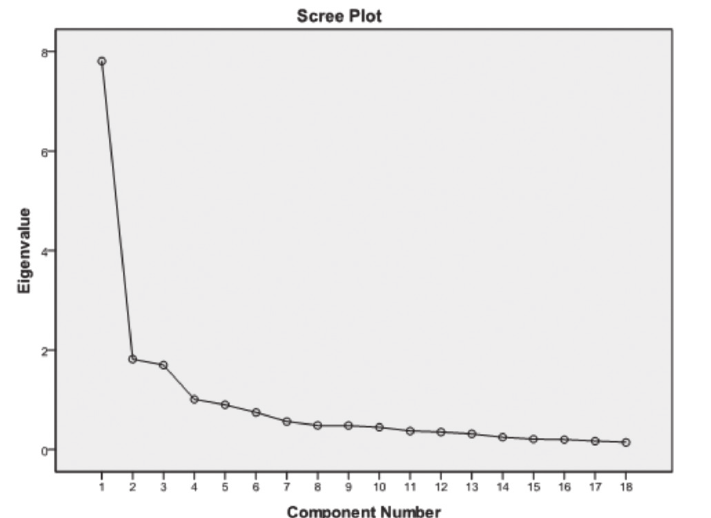
Figure 1: Scree plot for Initial Factor